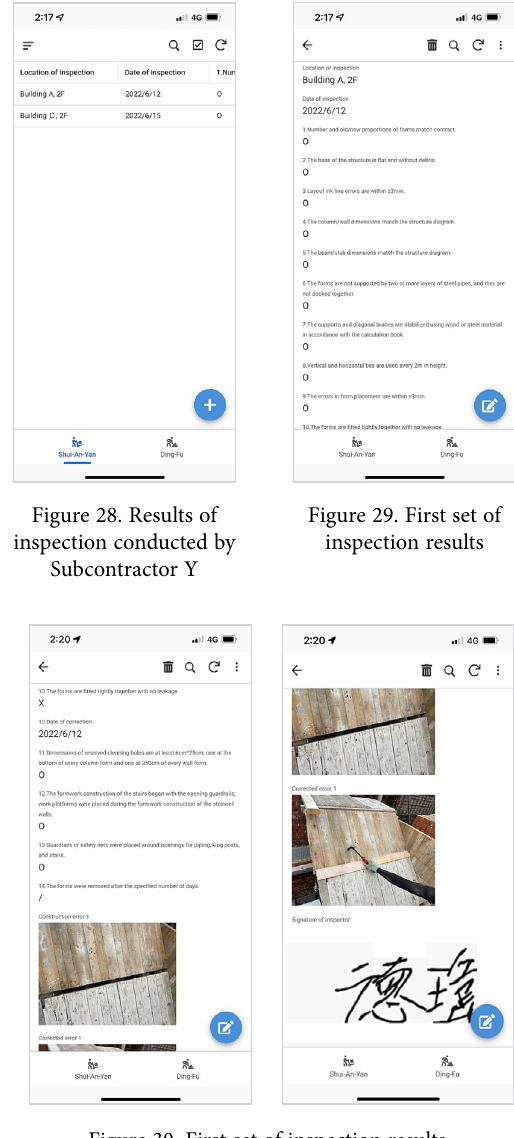
Figure 30. First set of inspection results